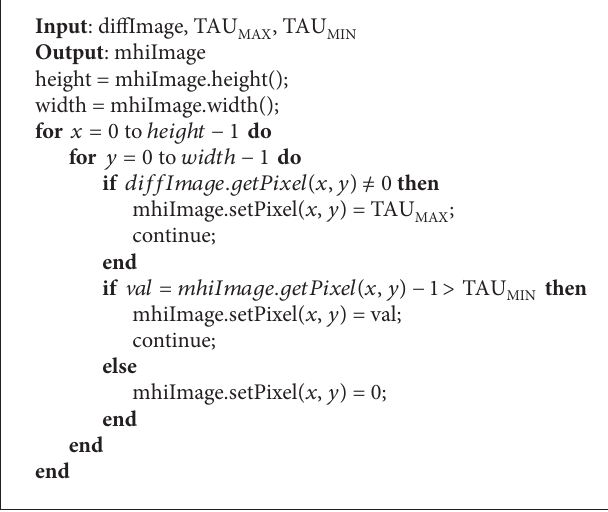
Algorithm 1: Computation of MHI.